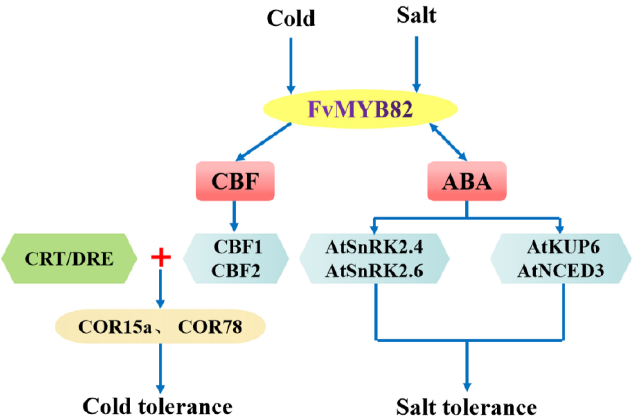
Figure 11. Model of FvMYB82 response to low temperature and salt stress. Salt stress promotes expression of FvMYB82 , increases the ABA biosynthesis and expression level of signal transduction genes SnRK2.4 SnRK2.6 , and improves salt tolerance. Subsequently, ABA production stimulates the expression of FvMYB82 . In addition, salt stress induces the expression of the crucial salt-responsive genes AtKUP6 and AtNCED3 and increases plant salt tolerance. Cold stress induces the expression of FvMYB82 , and FvMYB82 domain binds to the promoter regions of CBF1 and CBF2 and promotes binding of CBFs to the CRT/DRE cis -acting elements of downstream genes, thereby activating expression of the downstream cold-responsive genes COR15a and COR78 . It also enhances plant cold tolerance.